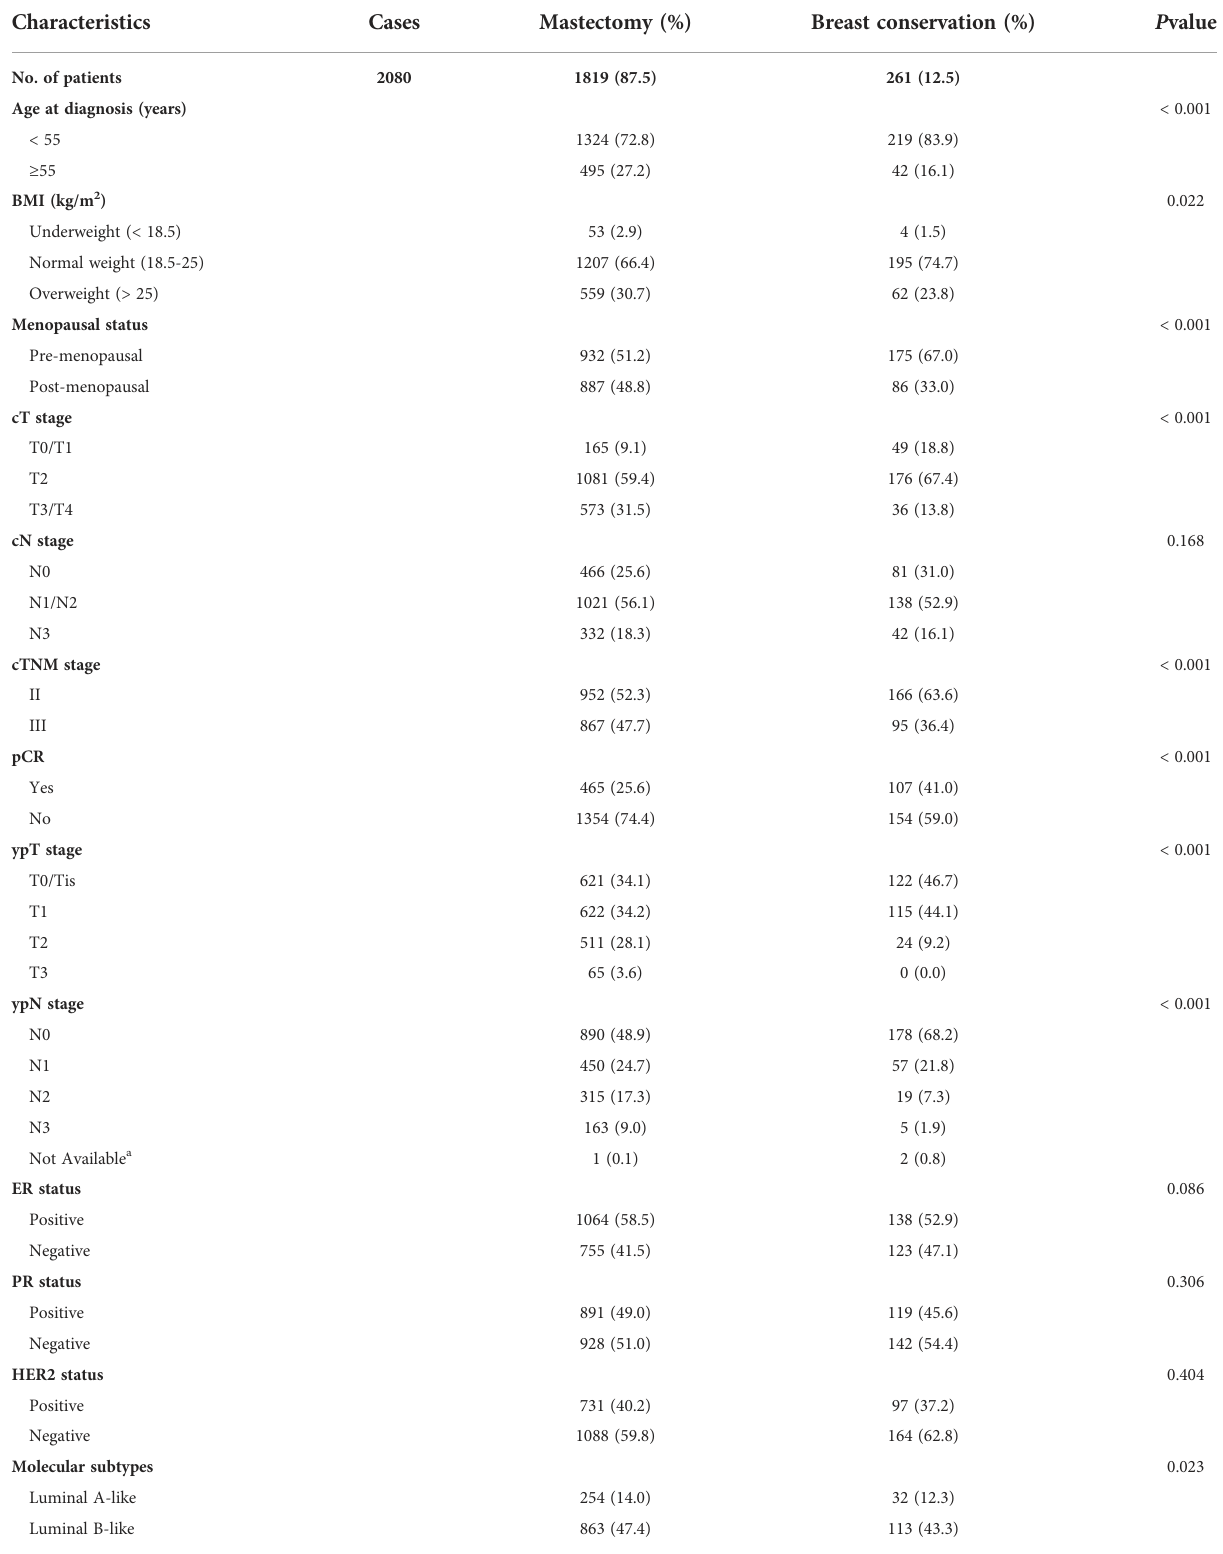
TABLE 1 Characteristics of patients in mastectomy and breast conservation